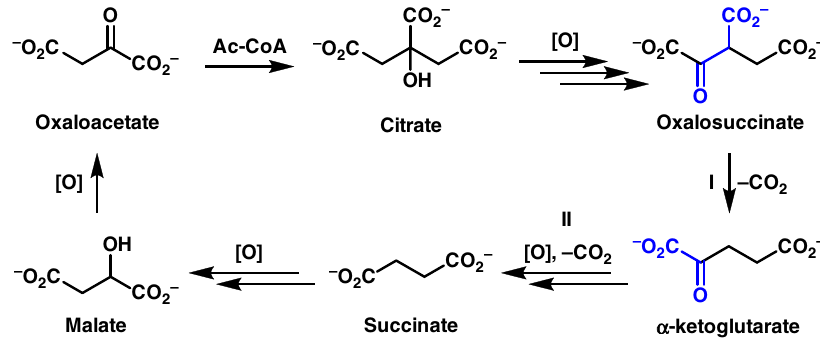
Fig. 1 Oxidation and decarboxylation within the modern TCA cycle. A net transformation of Ac-CoA into CO 2 occurs through a decarboxylation of a β - ketoacid (I) and an oxidative decarboxylation of an α -ketoacid